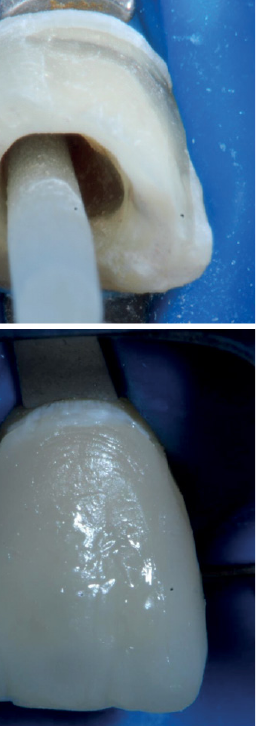
Figure 4. A. Flared root canal prepared to receive a fiber post; B. Note that the shape and diameter of post-hole is non-uniform, resulting in a mismatch between the fiber post and root canal walls; C. Relining procedure with composite resin; D Significant volume of composite covering the fiber post; E. Final direct composite restoration. In the absence of post relining, all this volume will be filled with resin cement during the cementation